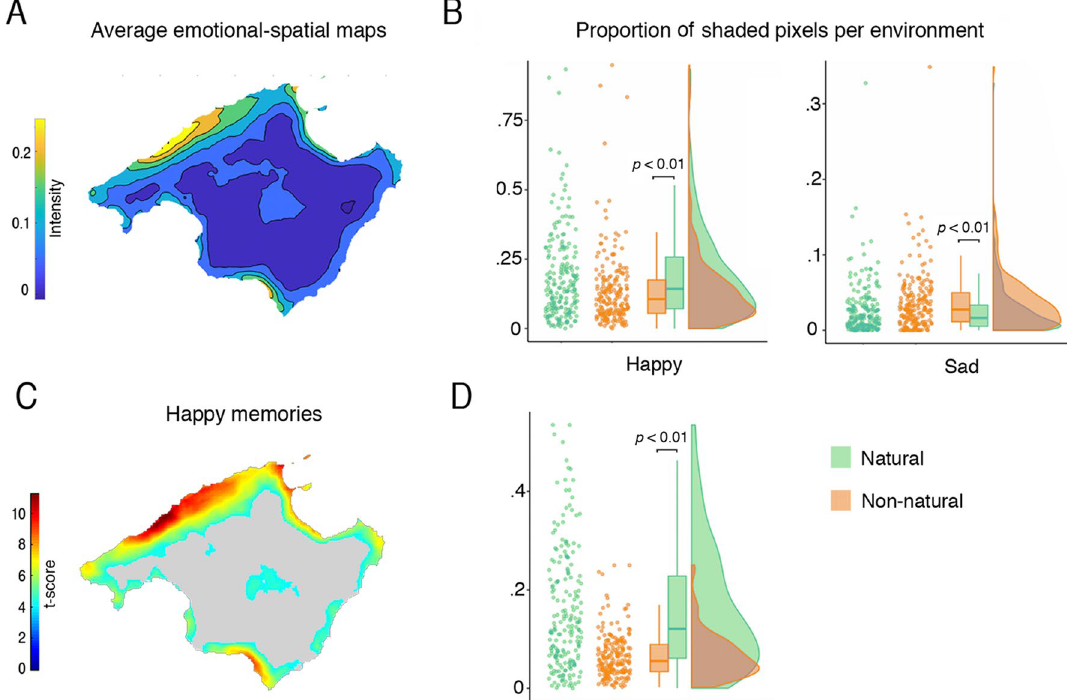
Figure 3. Spatial maps of emotional memories. ( A ) Subject-wise emotional-spatial maps that combine happy and sad memory maps. The colorbar denotes participants’ mean intensity response (warmer colors for happier memories in space). ( B ) We quantified the proportion of pixels that participants shaded for each environment (according to the total number of pixels in natural or non-natural environments), and the proportion of these shaded regions for each emotion. Here, a significant interaction with follow-up analysis showed that happy memories occurred more in natural environments and vice versa (p < 0.001). ( C ) SPM analyses of the subject-wise emotional-spatial maps showed significant areas only for happy memories (i.e., consistent mapping significantly > 0; FWE corr.). ( D ) We also quantified the number of pixels per environment in the significant SPM clusters of panel ( C ). The number of pixels in natural environments was greater than in non- natural ( p < 0.01); bars denote the t-statistic range; n = 201; comparisons between environments computed via Wilcoxon’s statistical test. Outline maps are under Creative Commons license CC0 from